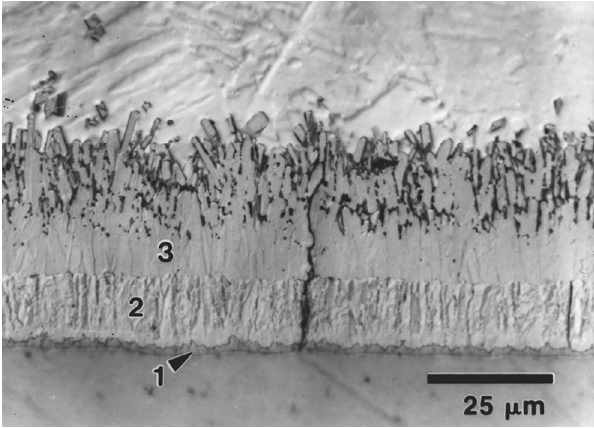
Fig. 7 Microstructure of Zn coating formed after 300 s immersion in a 450 ° C pure Zn bath on an ultra-low-carbon (ULC) steel substrate. Phases formed are (1) gamma,  ; (2) delta,  ; and (3) zeta,  . Reproduced with permission from Ref. [32], © Elsevier, 2000.